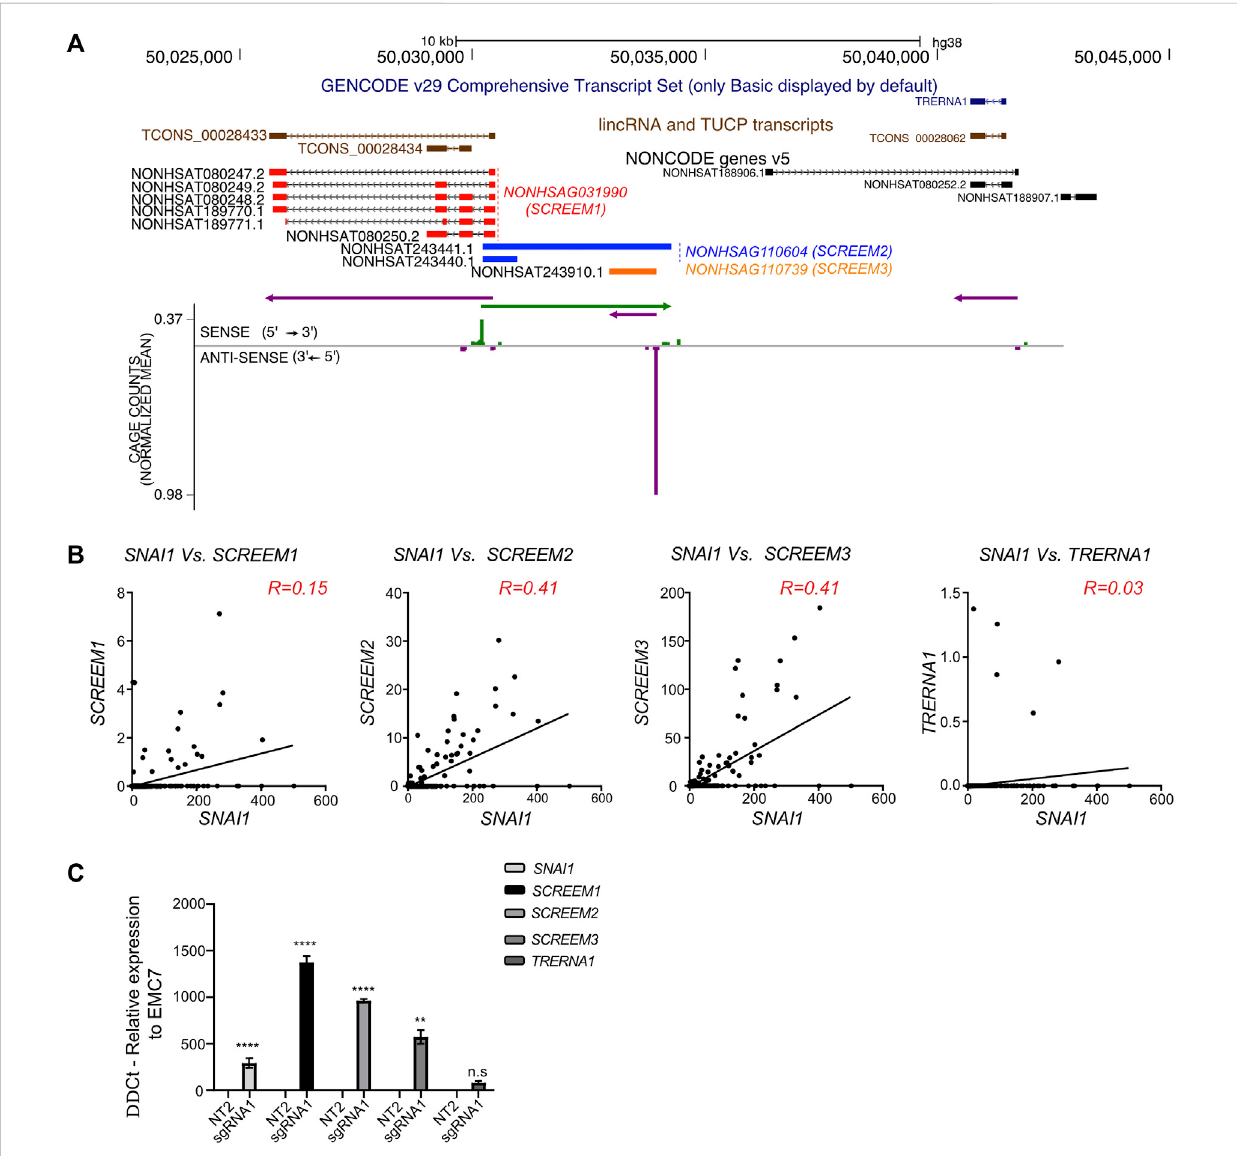
Genomicregionproximalto SCREEM1 containsmultipleeRNAs. (A) Top,UCSCgenomebrowserviewofthe SCREEM1 locusanditsproximalgenes. On the top the GENCODE v29 (dark blue), lincRNA and TUCP transcripts (brown) and NONCODE (red, SCREEM1 ; blue, SCREEM2 ; orange, SCREEM3 ) annotations are shown. Bottom, plotted normalized CAGE counts mapped to a 5 ′ cap of SCREEM1 , SCREEM2 , and SCREEM3 (counts shown are from all samples inFANTOM5). (B) Normalized CAGE counts mappedtoa5 ′ capof SNAI1 , SCREEM1 , SCREEM2 , and SCREEM3 andTRERNA1 (counts shown were extracted from all samples in FANTOM5). R values were calculated using simple linear regression. (C) SNAI1 , SCREEM1 , SCREEM2 , and SCREEM3 expression in HBEC3-KT cells upon CRISPR-activation of TCONS_0002834 locus. Plotted are delta-delta Ct values relative to NT and EMC7 from RT- PCR; NT, non-targeting. All values are mean ± SD with n = 3; Statistics, unpaired t -test, **** p < 0.0001; *** p < 0.001; ** p < 0.01; n.s, not signi fi